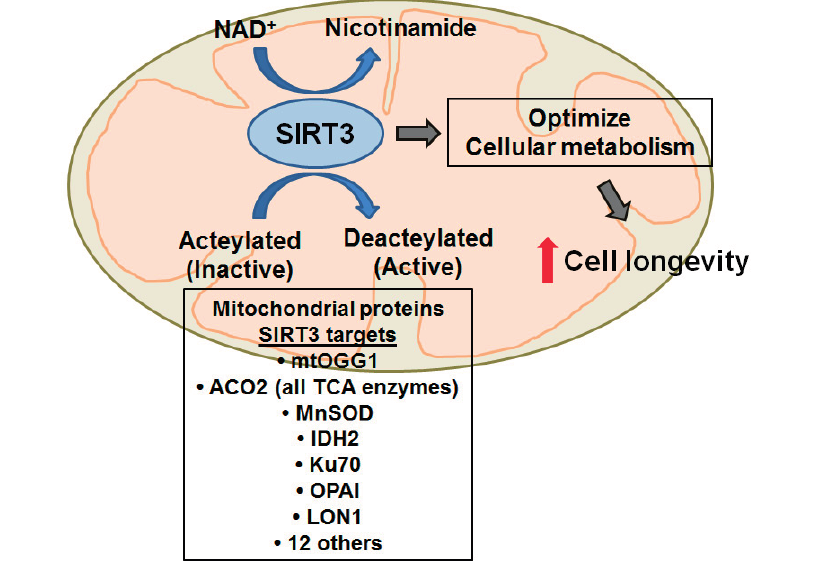
Figure 3. SIRT3 mitochondrial protein deactylation targets modulate cell metabolism and longevity. Red-up arrow,